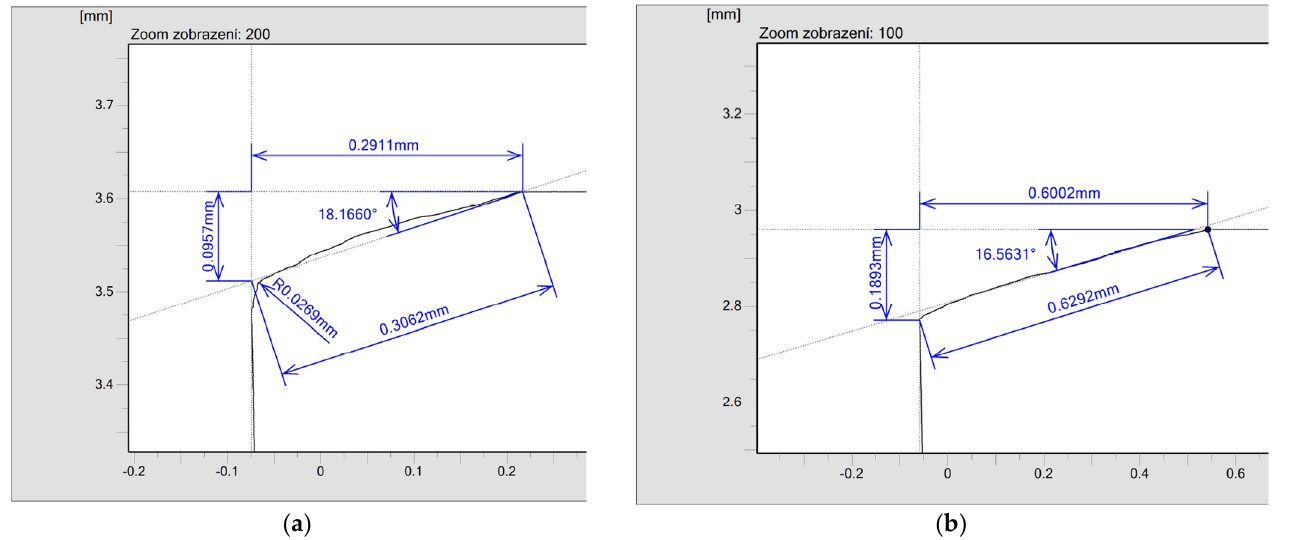
Figure 7. Dimensions of created asymmetrical chamfers: ( a ) 0.3 mm × 20°, ( b ) 0.6 mm × 20°. Similar results were achieved for the elliptical roundings 0.25 × 0.1 mm (Figure 8a) and 0.5 × 0.2 mm (Figure 8b). However, higher inaccuracy can be seen. The dimensions of the major semi-axis of the ellipse (0.25 and 0.5 mm) were measured on the horizontal axis and the dimensions of the minor semi-axis of the ellipse (0.1 and 0.2 mm) were measured on the vertical axis.